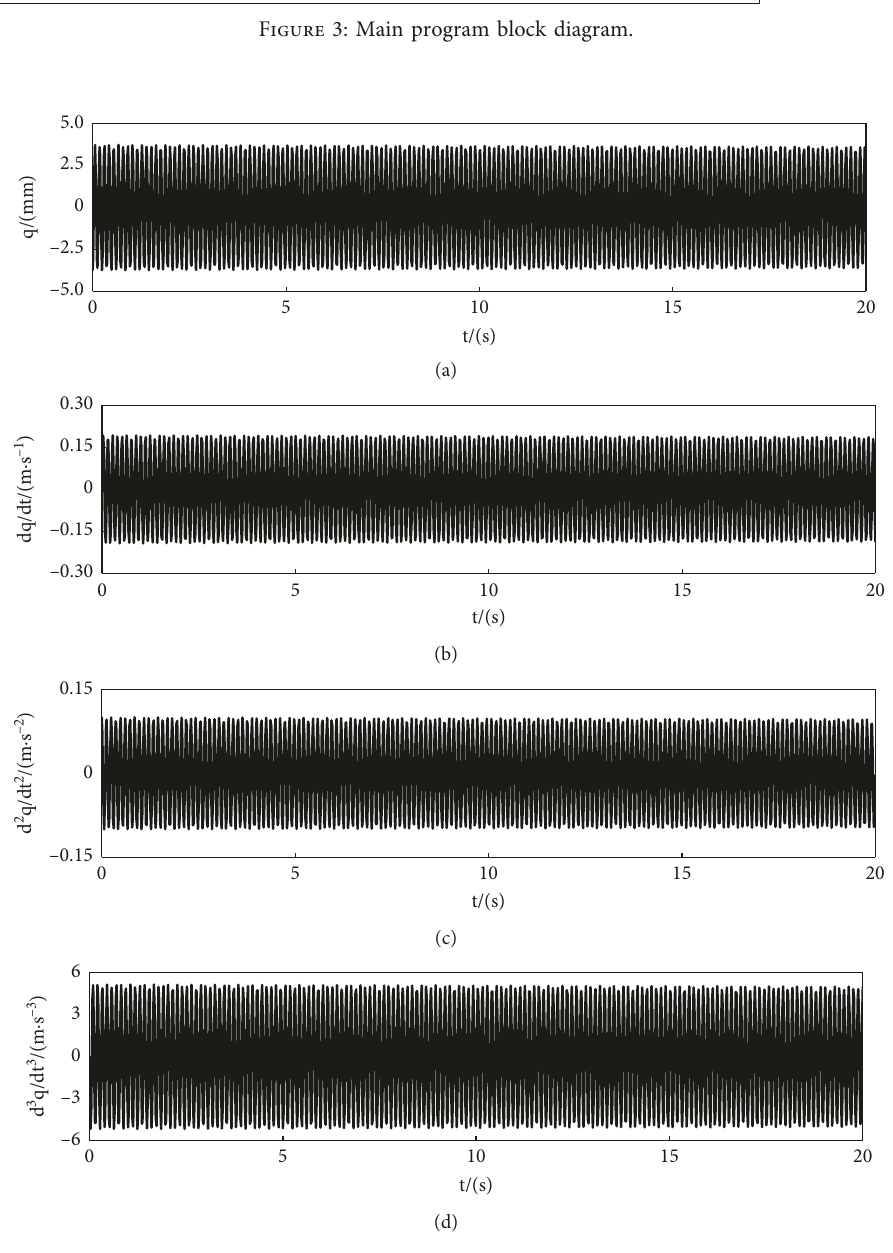
Figure 4: Response curve without control using sliding mode control